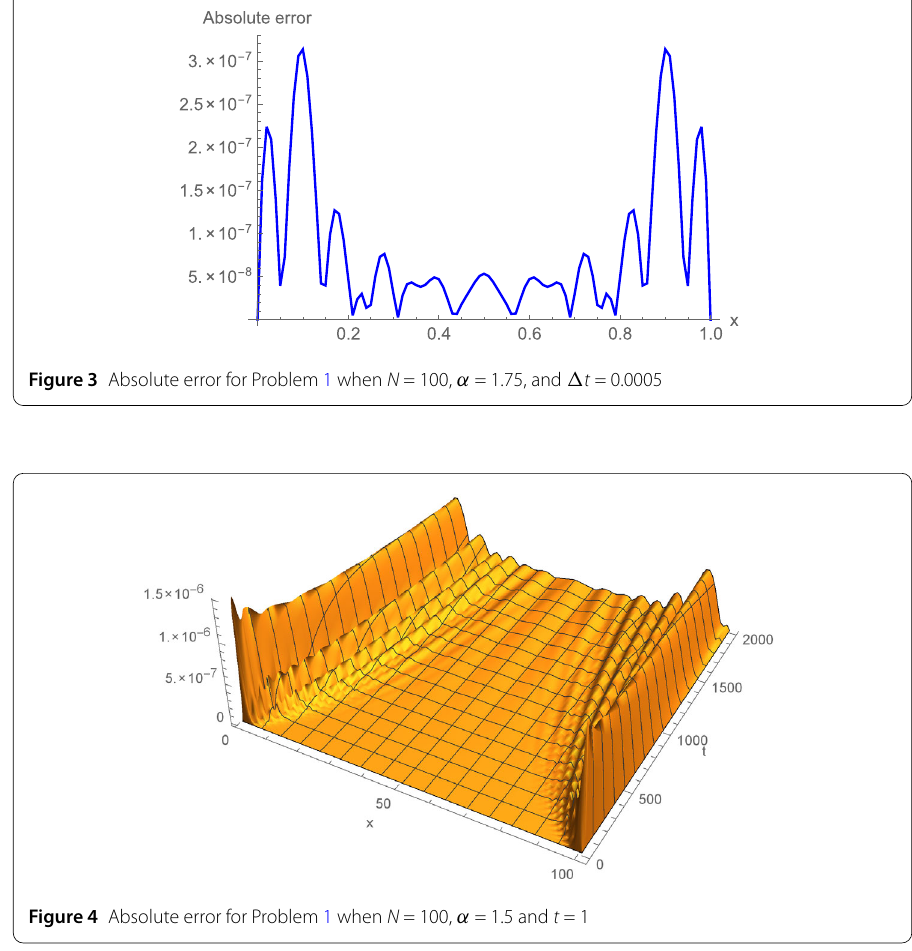
with the exact solution, which indicates that the proposed method is effective. Figure 3 displays the absolute error at t = 1 with α = 1.75 and N = 100, whereas Fig. 4 represents 3D error plot using N = 100, α = 1.5, and (cid:2) t =